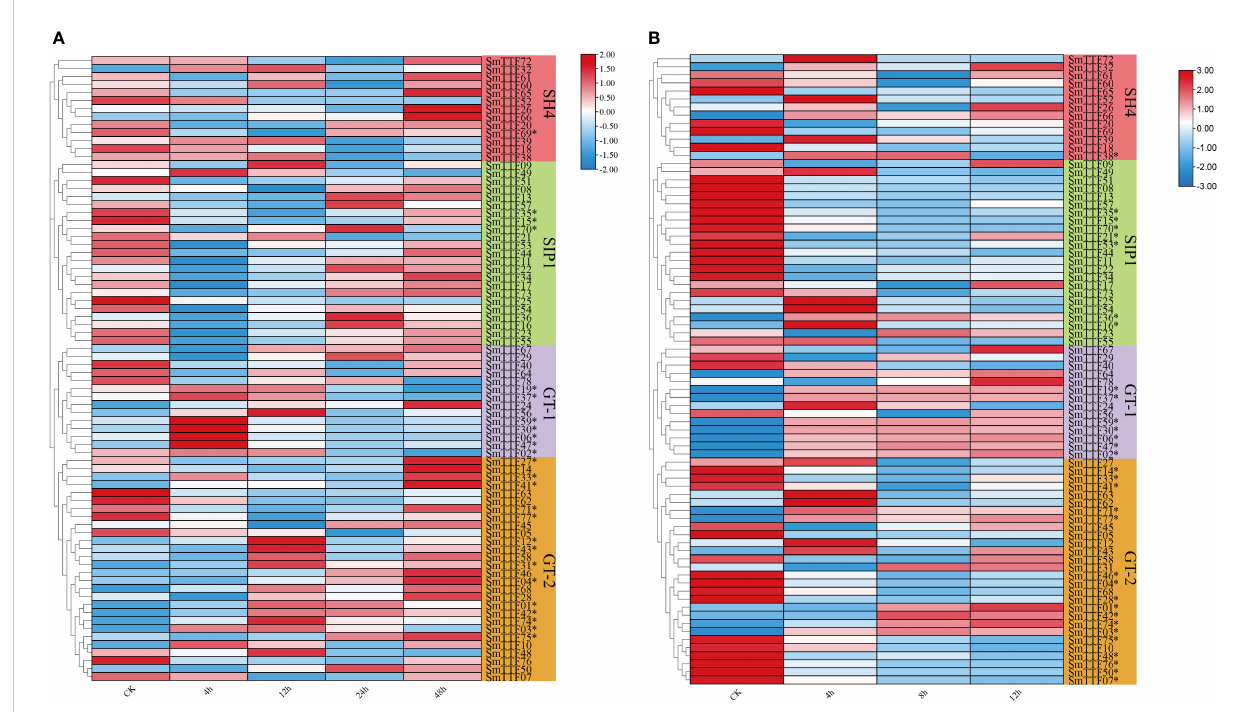
FIGURE 7 Heatmap of the expression pro fi les of Salix matsudana trihelix genes under submergence stress and salt stress. (A) Expression pro fi les of trihelix genes under fl ooding stress. (B) Expression pro fi les of trihelix genes under salinity stress. Differentially expressed genes are marked with *. The expression values (Fragments per kilobase for a million reads, FPKM) for each gene were log2 transformed before generating the heatmap.